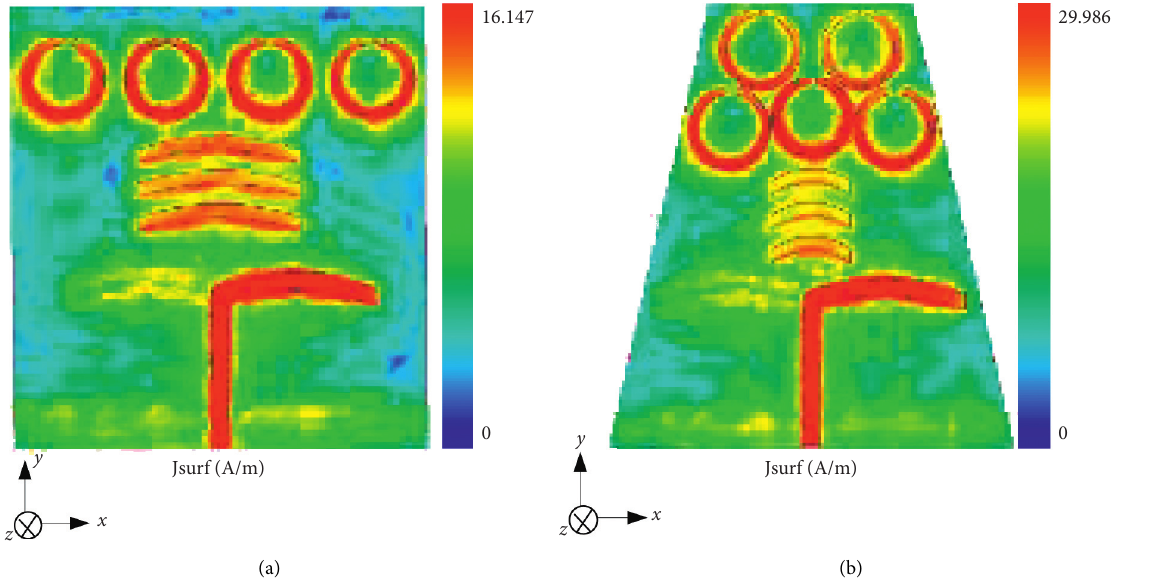
Figure 9: Simulated surface current distribution of the compact quasi-Yagi antennas. (a) Rectangle shape. (b) Trapezoid